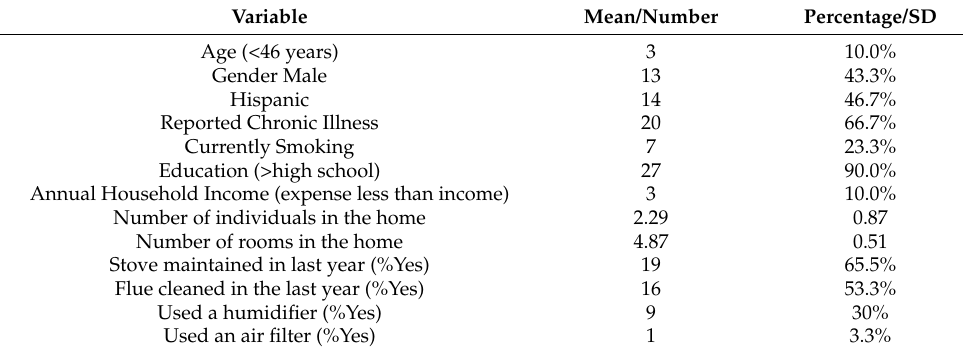
Table 1. Characteristics of the study participants in 30 homes studied.